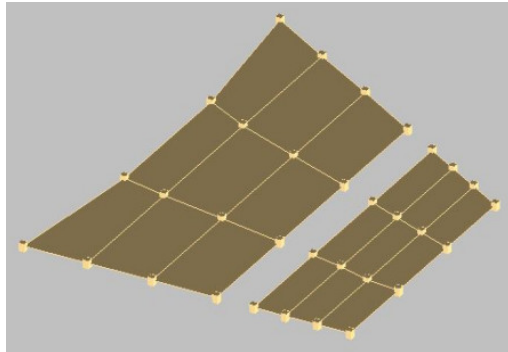
Figure 4. Similar model ground test process.